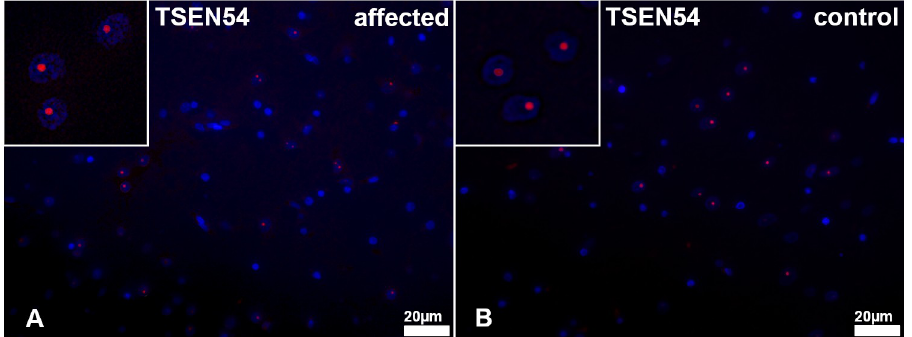
Fig 10. TSEN54 immunofluorescence of the white matter in the centrum semiovale of the cerebrum. (A) Affected puppy no. 1 and (B) age matched healthy control no. 1009. There is an almost equal number and distribution of cells showing an intranuclear positive signal for TSEN54 (red). Insets show TSEN54 + cells in a higher magnification.